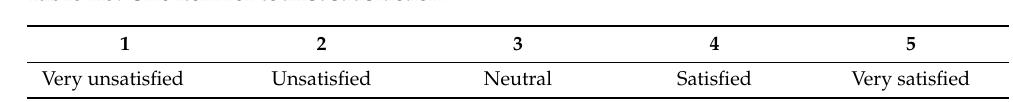
Table A5. One item for tourist